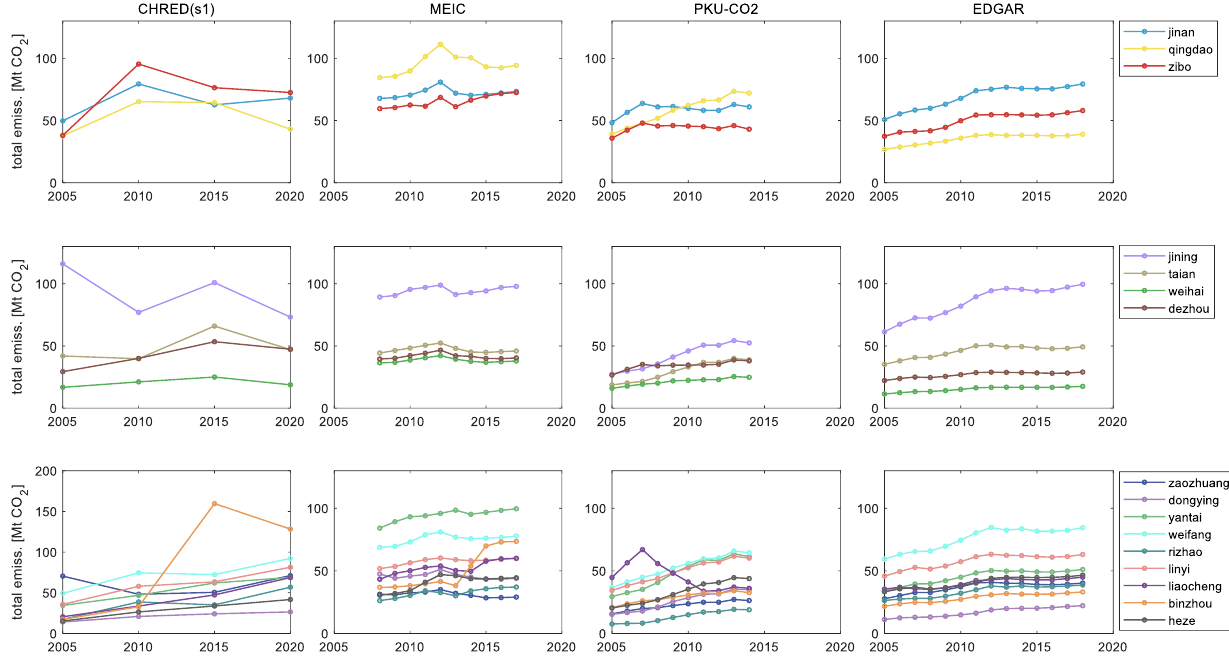
Figure 5. Evolution of aggregated city-level CO 2 emissions from four inventories from 2000 to 2020 for three groups of cities. The definitions of the groups are described in the paper.